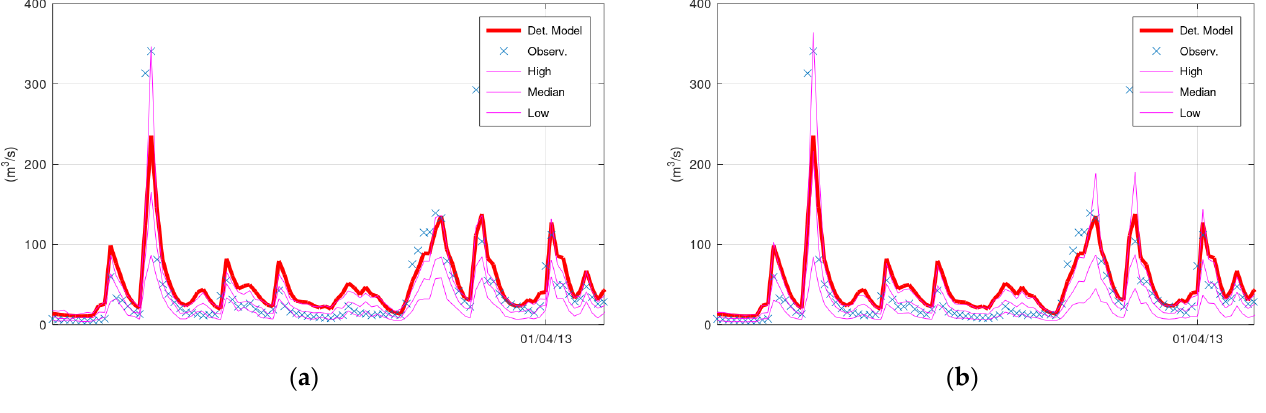
Figure 2. Discharge of Arno River, 100 days of the validation period starting from 1 January 2013: ( a ) KNN; ( b ) Bluecat. “Det. Model” is the simulation with HyMod.